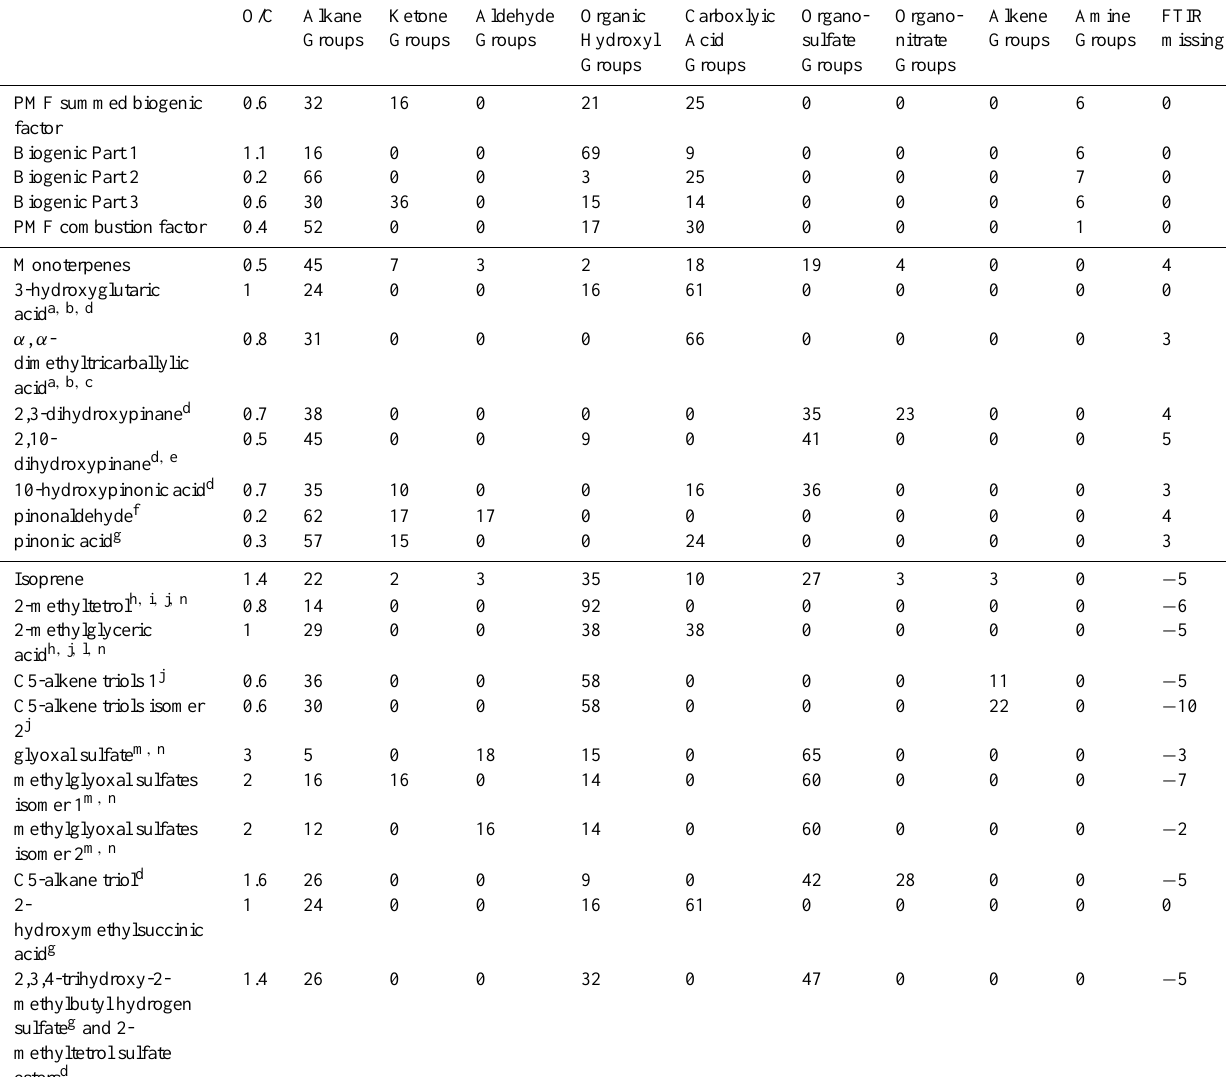
Table 2. OFG Fractional Composition of FTIR Factors and reported biogenic SOA from Hallquist et al. (2009) Tables 3, 4 and 5. O/C Alkane Ketone Aldehyde Organic Carboxlyic Organo- Organo- Alkene Amine FTIR Groups Groups Groups Hydroxyl Acid sulfate nitrate Groups Groups missing Groups Groups Groups Groups